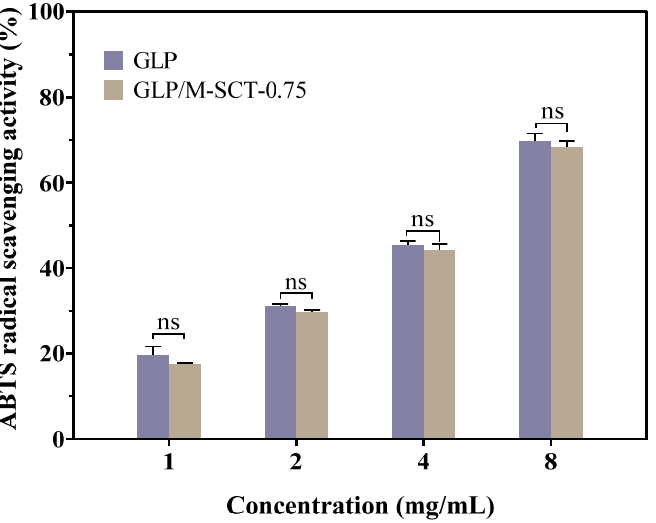
Figure 8. GLP/M-SCT-0.75 hydrogel does not affect the original antioxidant activity of GLP. The ability of GLP and GLP/M-SCT hydrogels to scavenge ABTS radicals was measured and compared using the ABTS radical scavenging activity assay kit. n = 3, data are presented as means ± SE; ns, not signi fi cant.